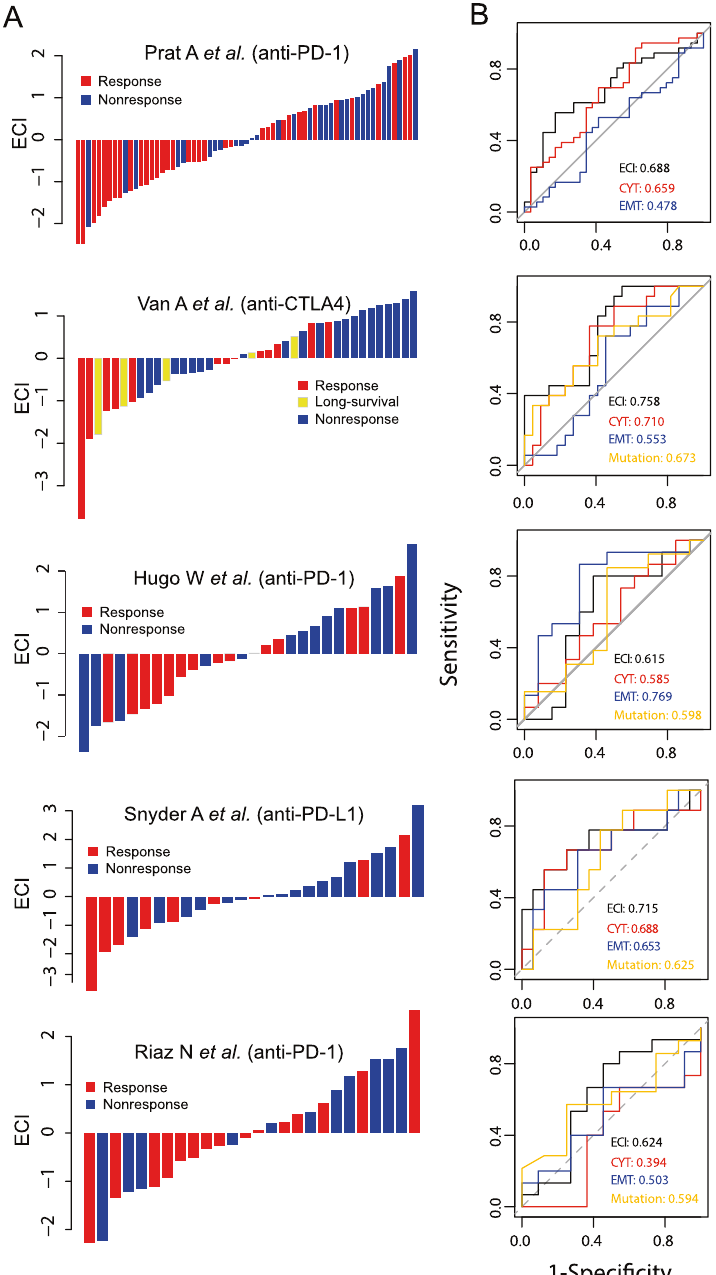
Fig. 3 ECI predicts response to immune checkpoint blockade. A ECI and ICB response of patients in fi ve independent immunotherapy datasets. Tumors were sorted according to their ECI. B Receiver operating characteristic curves for ICB response for the ECI, CYT, EMT and TMB of the fi ve independent immunotherapy datasets. CYT cytolytic activity, EMT epithelial-mesenchymal transition, ECI EMT-CYT index, ICB immune checkpoint blockage, TMB tumor mutation